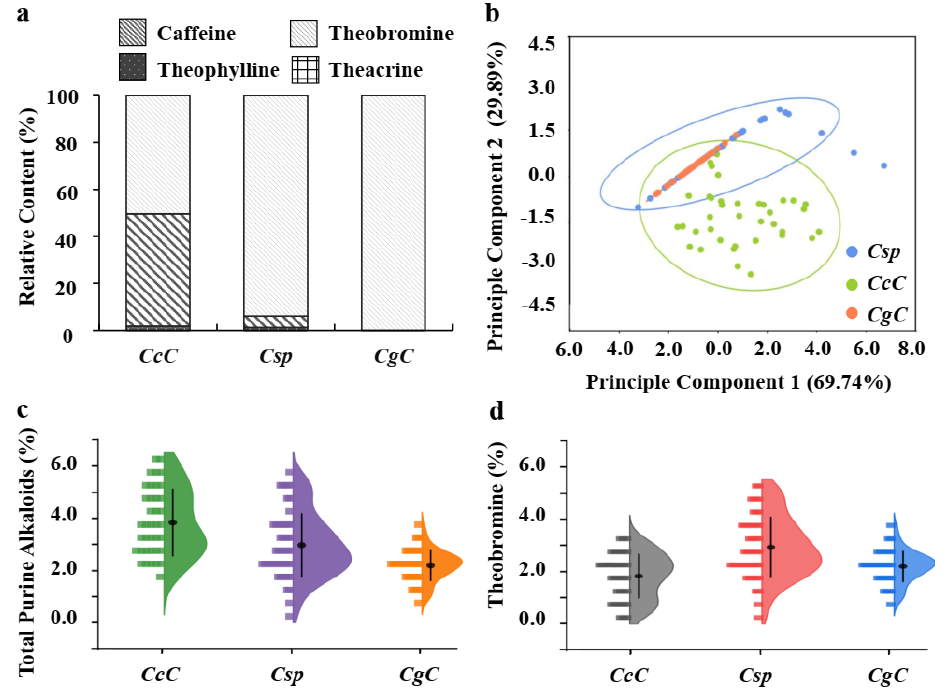
Figure 3. Distribution of purinealkaloids in three Camellia species. ( a ) Relative contents of four purine alkaloids; ( b ) principal component analysis (PCA) of four purine alkaloids derived from 126 accessions wild tea tree samples of three Camellia species; ( c ) percentage of theobromine in three Camellia species (percentage of dry weight); ( d ) percentage of total purine alkaloids in three Camellia